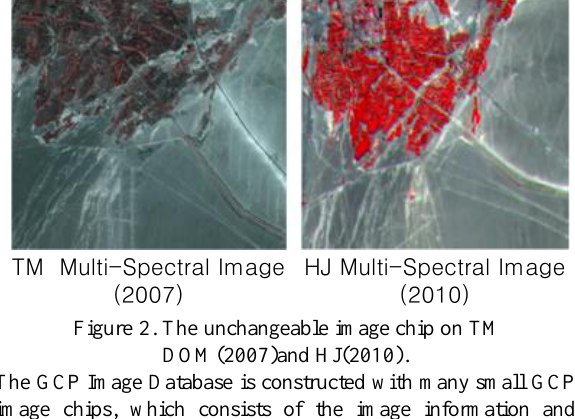
Figure 2. The unchangeable image chip on TM DOM(2007)and HJ(2010).